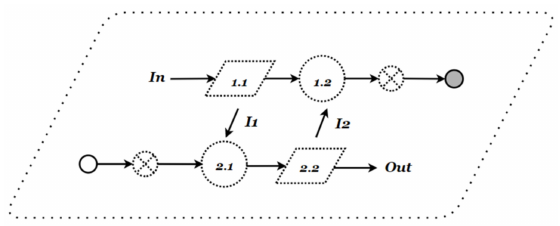
Figure 10. The Operations Plane focuses on transformational activities.